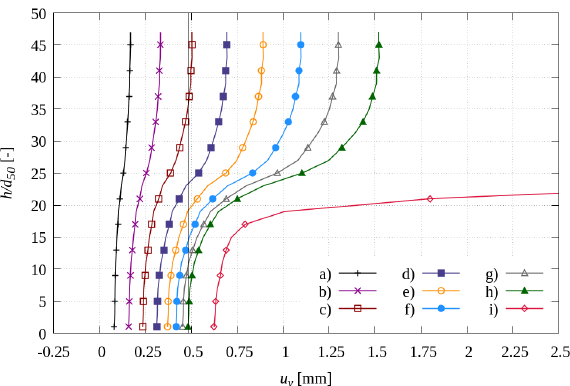
Figure 19: Distribution of horizontal sphere displacement u’ the normalized specimen height h / d u = 0.25 mm, b) u x u = 1.25 mm, f) u x u = 10.00 mm ( e x line demonstrates 5% limit).